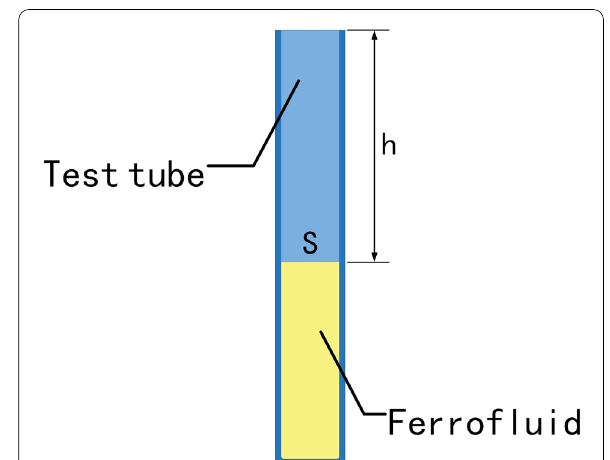
Figure 2 Ferrofluid in a test